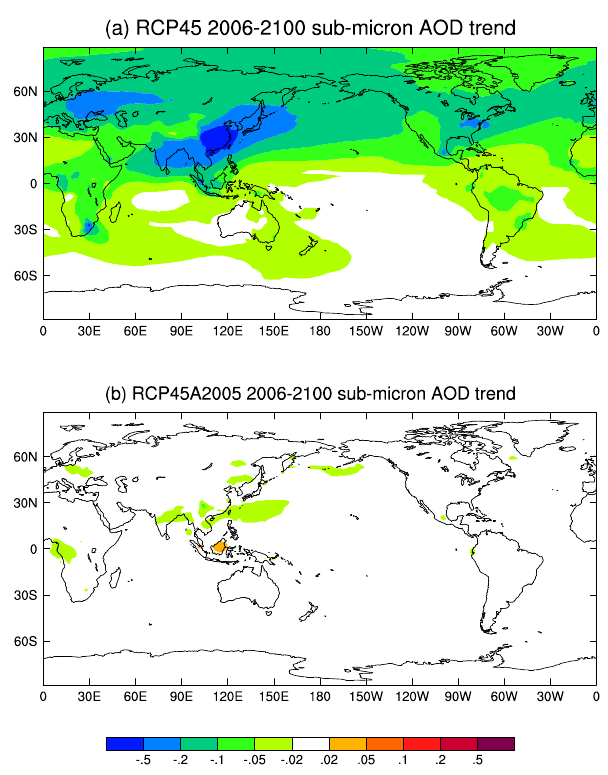
Fig. 2. 2006–2100 trends of annual-mean, sub-micron clear-sky AOD at 550nm (AOD units per century) from (a) RCP45, and (b)